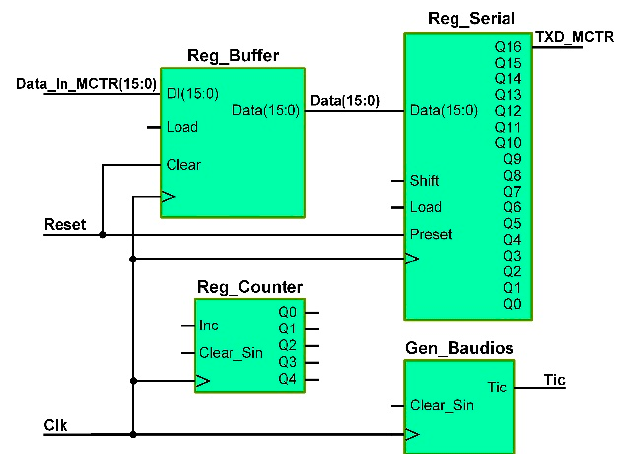
Figure 11. MCTR Entity Transmitter FSMD data path.